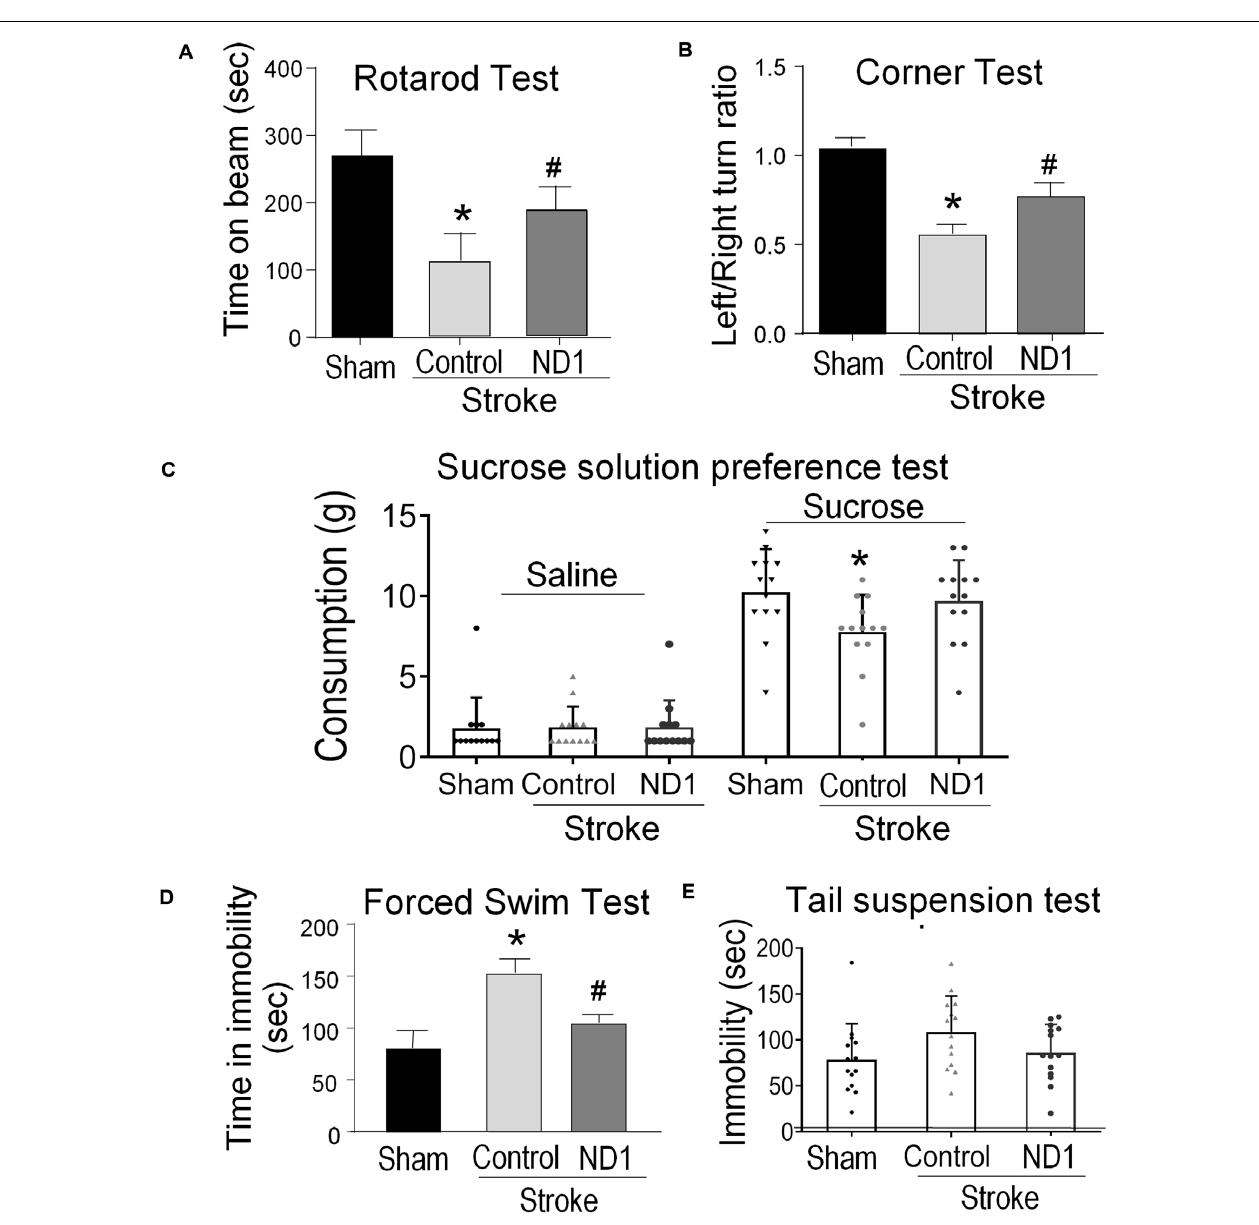
FIGURE 7 | Direct conversion of astrocytes to neurons improved functional recovery after stroke. Functional and behavioral tests were performed different days after stroke to evaluate the therapeutic benefits of the direct conversion therapy using ND1 transduction. (A) The rotarod test was performed 21 days after stroke to measure the motor function of stroke animals. Stroke animals disabled a disability in balancing on the rotarod beam, their time spent on the beam was significantly shorter than sham control mice. ND1 conversion treatment noticeably improved the motor function of maintaining on the beam with a longer time. N = 6/group, two-way ANOVA (interaction: F (3,44) = 29.9, ∗∗∗ p < 0.0001 followed by Bartlett’s test). Sidak’s multiple comparisons test: * p < 0.05 vs. Sham, # p < 0.05 vs. vector control. (B) In the corner test, normal mice make equal left and right turns so the ratio of turns is close to 1.0. After a stroke, animals revealed a sensorimotor deficit of biased turn behavior due to the side of ischemic damage in the sensorimotor cortex. ND1 treatment showed a significant correction in this sensorimotor functional deficit. N = 6/group, two-way ANOVA (interaction: F (2,15) = 19.91, ∗∗∗ p < 0.001 followed by Bartlett’s test). Sidak’s multiple comparisons test: * p < 0.05 vs. Sham, # p < 0.05 vs. vector control. (C) Long-term psychological behaviors were tested 4 months after stroke. In the sucrose preference test, sham animals showed a marked increase in consuming the sucrose solution compared to saline, while stroke resulted in a significantly reduced interest in the sucrose solution. Stroke mice that received ND1 treatment maintained a similar interest in drinking the sucrose solution as sham mice. N = 12–14/group, one-way ANOVA ( F (2,36) 3.447, p = 0.0427), * p < 0.05 vs. Sham. (D) In the forced swim test, stroke mice exhibited significantly longer idle time in the water, indicative of a chronically developed post-stroke depression-like phenotype. This depression-like behavior was significantly corrected in stroke mice treated with ND1. N = 6/group, One-way ANOVA ( F (4,82) = 13.27, ∗∗∗∗ p < 0.0001) followed by Holm–Sidak’s multiple comparisons test: * p < 0.05 vs. before stroke, # p < 0.05 vs. stroke control. (E) Tail suspension test of depression-like behavior in rodents. Stroke mice were observed to spend a longer time immobile compared to sham controls. ND1 treatment yielded a trend of reducing the immobility time. N = 14/group, one-way ANOVA (interaction: F (2,39) = 2.53, ∗∗∗ p = 0.0926 followed by Bartlett’s test).